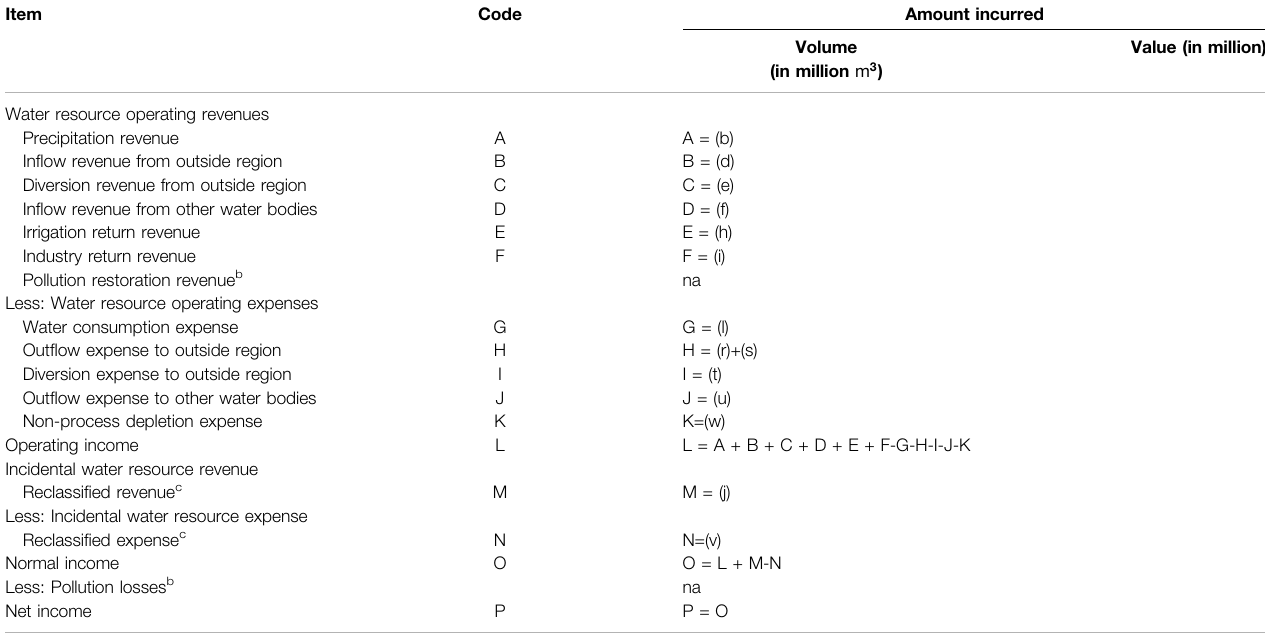
TABLE 2 | Regional water resource income statement a .